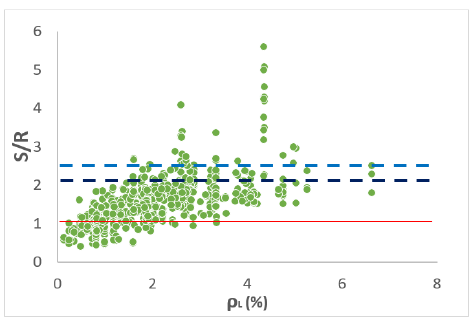
Figure 14- S/R in relation to